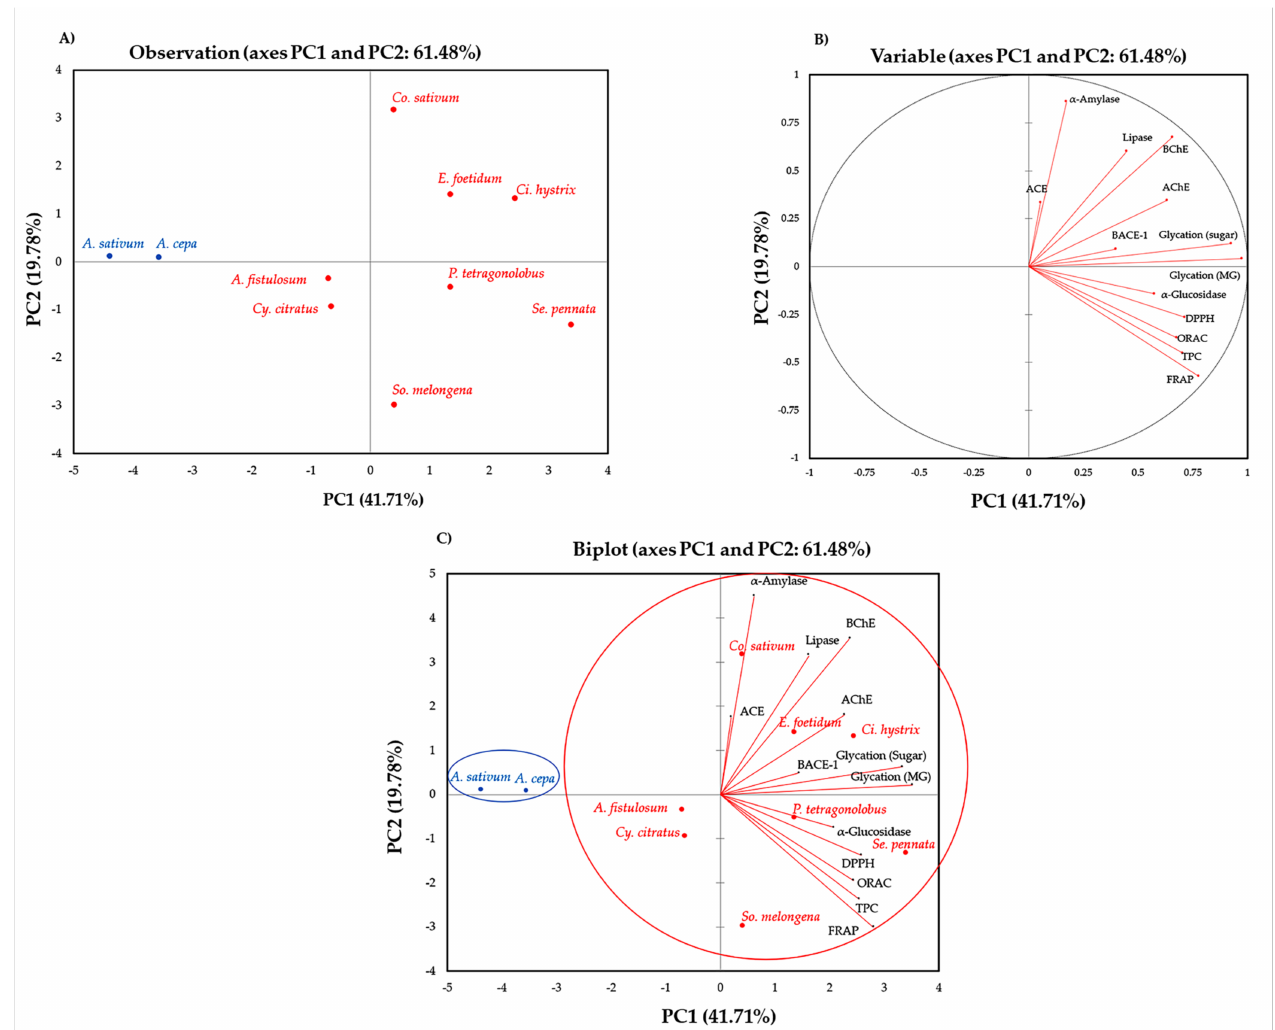
Figure 1. Principal component analysis (PCA) from mean values of all variables of ten vegetable extracts: ( A ) observation, ( B ) variable, and ( C )